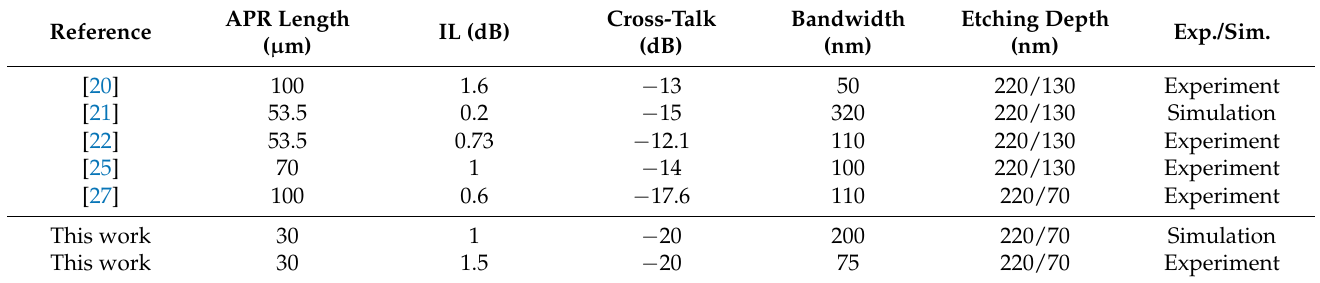
Table 2. Performance comparison of APR-based PSRs on the SOI